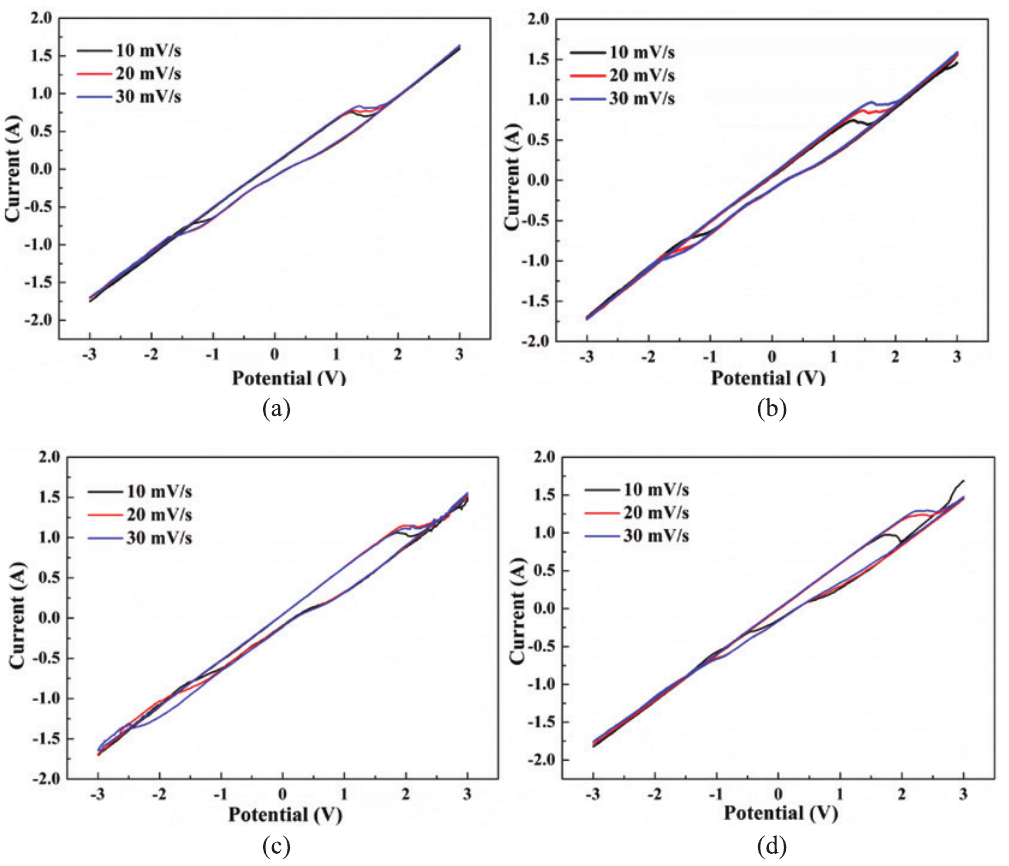
Fig. 2: Cyclic voltammograms obtained at different temperatures. (a) 880 °C; (b) 890 °C; (c) 900 °C; (d) 950